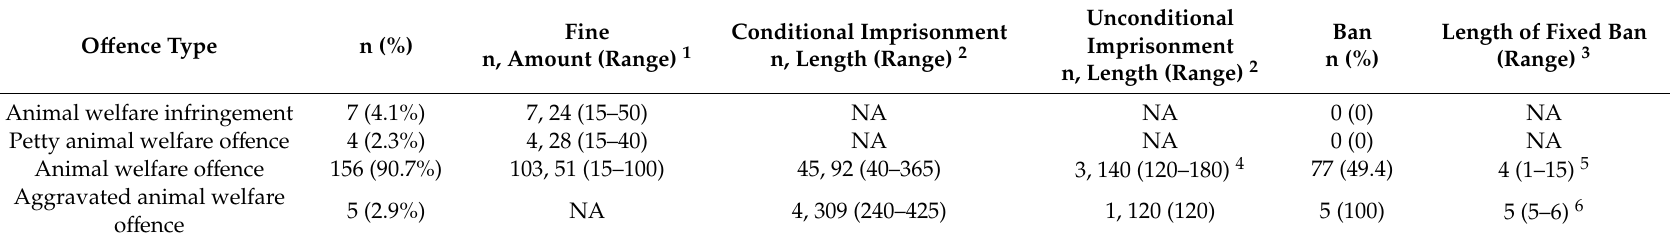
Table 2. Penalties and bans on the keeping of animals per o ff ence type for violations of cattle and pig welfare imposed by the Finnish district courts in